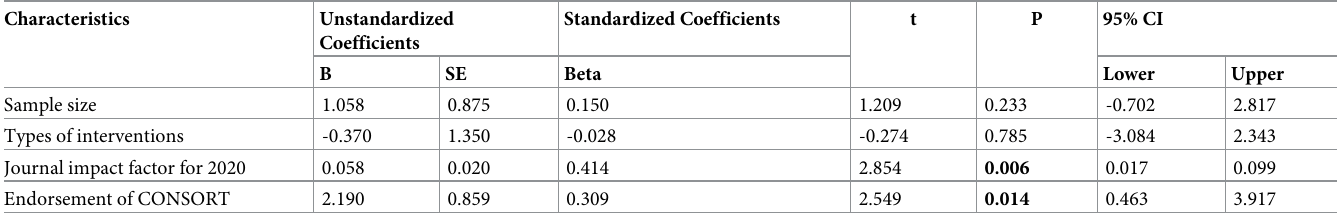
Table 3. Multiple linear regression determinants of reporting quality of RCTs.